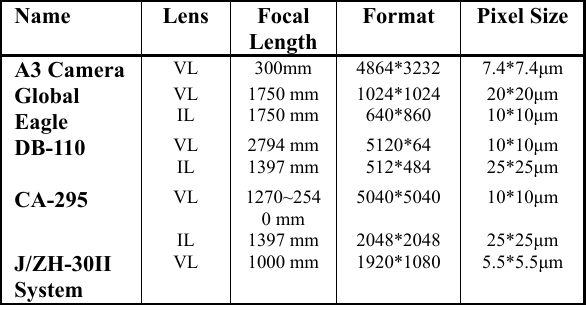
Image Coordinate System 𝒊 : The origin is located at the upper left corner of the image, set the moving direction of the platform as axis 𝐽 and the camera whiskbroom direction as axis 𝐼 . The horizontal coordinate and the vertical coordinate can be obtained according to the number of columns 𝑖 and rows 𝑗 of the image point. 2.2.2 Sensor Coordinate System 𝒄 : The origin is located at the perspective centre 𝑆 , 𝑌 𝐶 axis points to the moving direction of the platform, 𝑋 𝐶 axis is the reverse direction of the scanning direction and 𝑍 𝐶 axis is determined according to the right-hand rule. It is similar to the image space coordinate system in